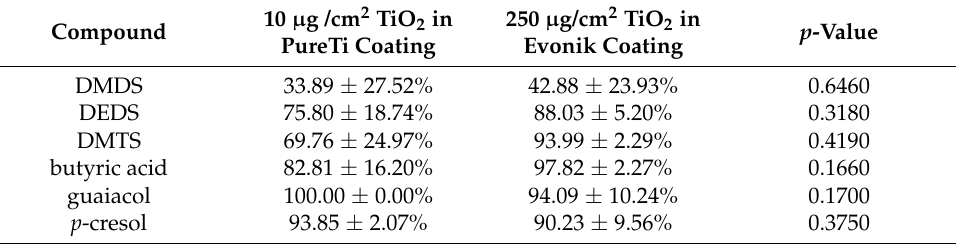
Table 9. Comparison of VOC removal rates using PureTi coating and Evonik